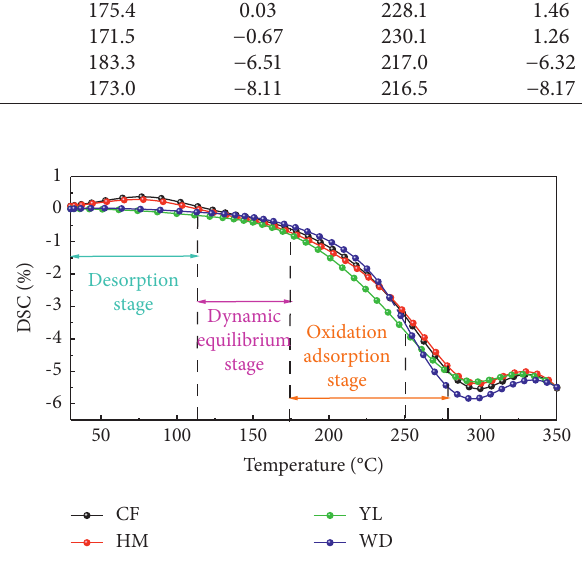
Figure 3: DSC curves and stage division of the coal samples. Table 3: Maximal heat release rate and corresponding temperature of each sample at different temperature-rise